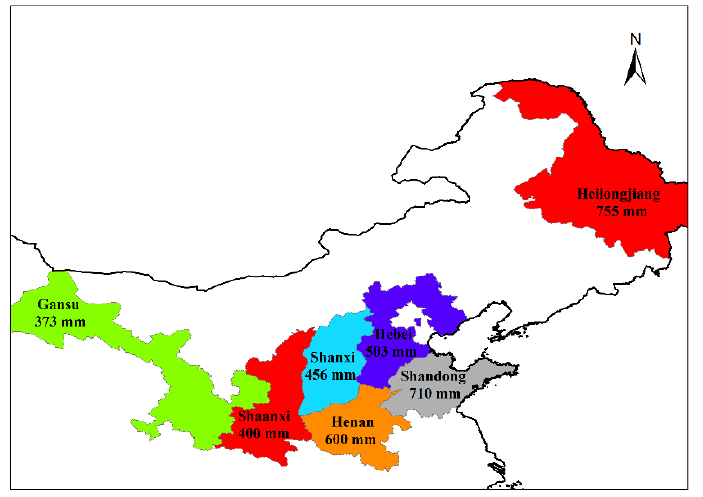
Figure 1. Distribution map of average rainfall of 65 genotypes from 7 provinces in China